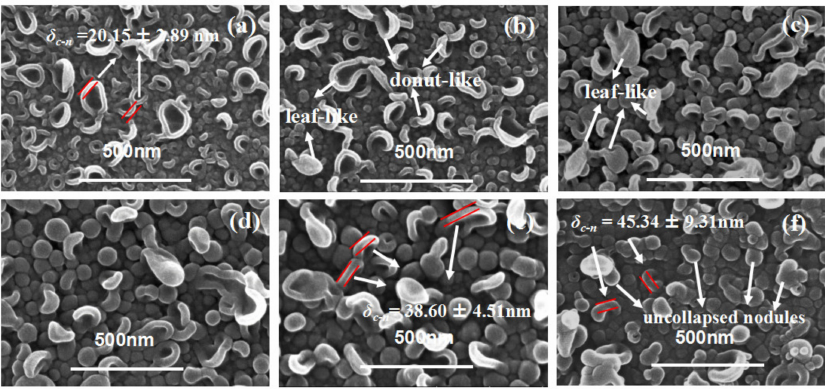
Figure 1. SEM image of PA’s top surface. ( a – f ): TFC − 1~TFC − 6. Theoretically, δ c-n is approximately twice δ int . We measured the thickness of the edge ( δ c-n ) of the “donut-like” or the leaf-like structures (i.e., collapsed nodules). As Table 2 shows, the δ c-n is only 20.15 ± 2.89 nm of TFC − 1; it gradually increased by 50% to be 29.20 ± 1.91 nm when c (MPD) was increased to 1.1%, then further continued to go up to be 45.34 ± 9.31 nm of TFC − 6. This observation agrees well with our previous study